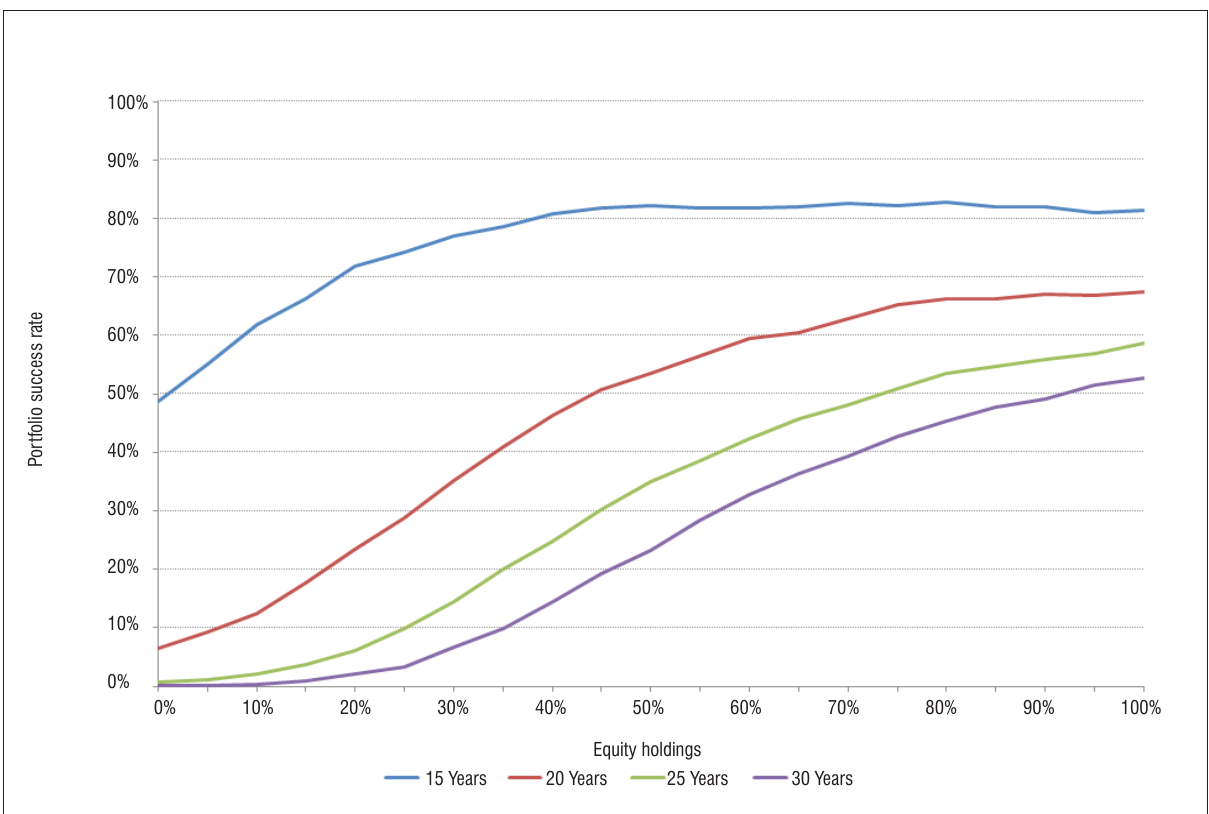
Figure 2: Portfolio success rate for 7.5% withdrawal